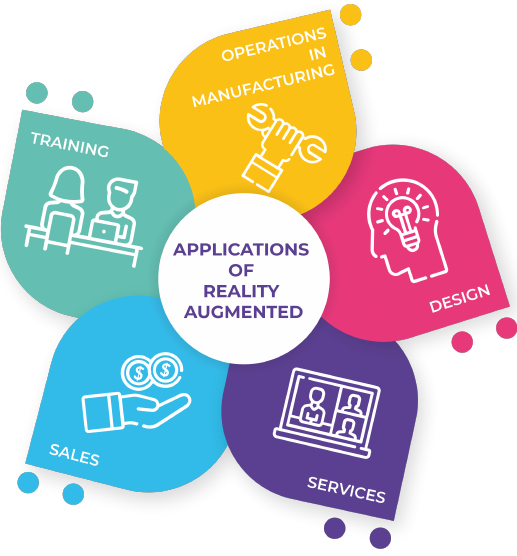
Figure 1. Applications of Augmented Reality in Industry